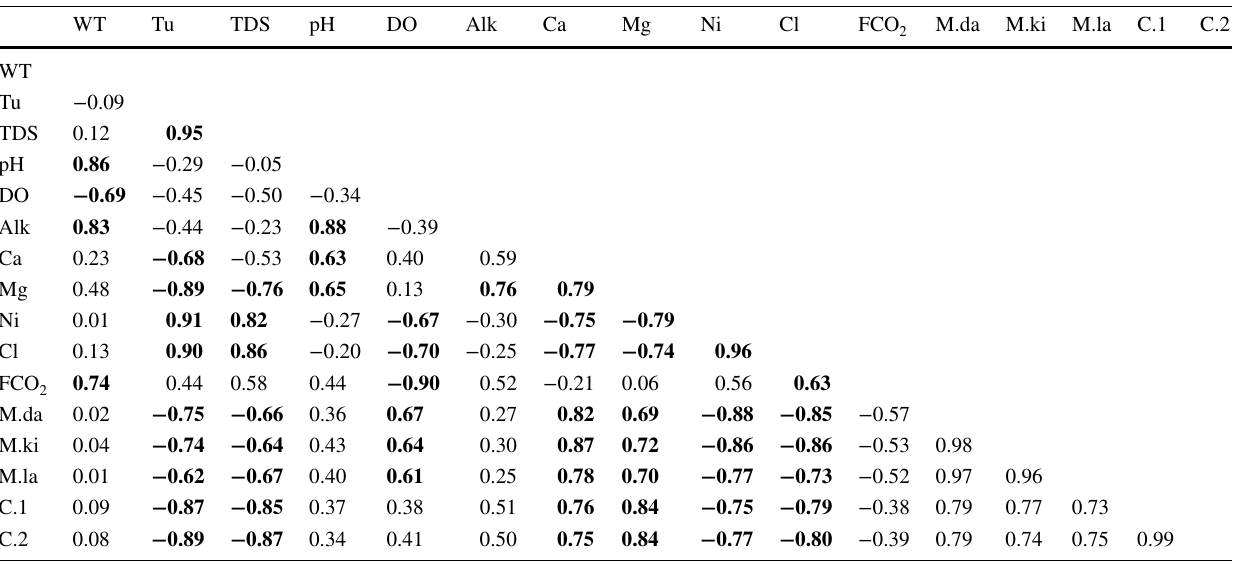
Bold values indicate a significant correlation ( p <